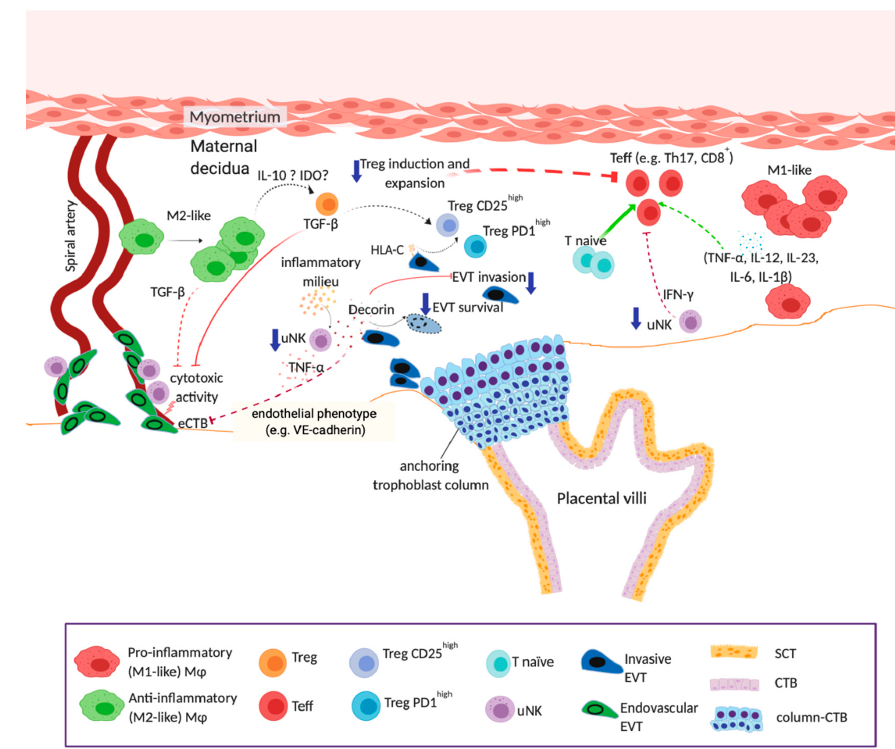
Figure 3. Proposed model of the effects of obesity on the intrauterine environment. Obesity-linked inflammation may affect uterine immune cell biology by: ( a ) disrupting the crosstalk between trophoblasts and uterine leukocytes resulting in impaired trophoblast invasion and artery remodeling [129,185,211,224,243–245], and ( b ) creating imbalances in immunoregulatory and pro-inflammatory uterine leukocytes that in turn potentiate maternal-fetal intolerance [60,211,246,247]. When inflammation is present in the intrauterine environment, homeostasis is disrupted leading to alterations in the frequencies and functions of important immunoregulatory cell populations that in